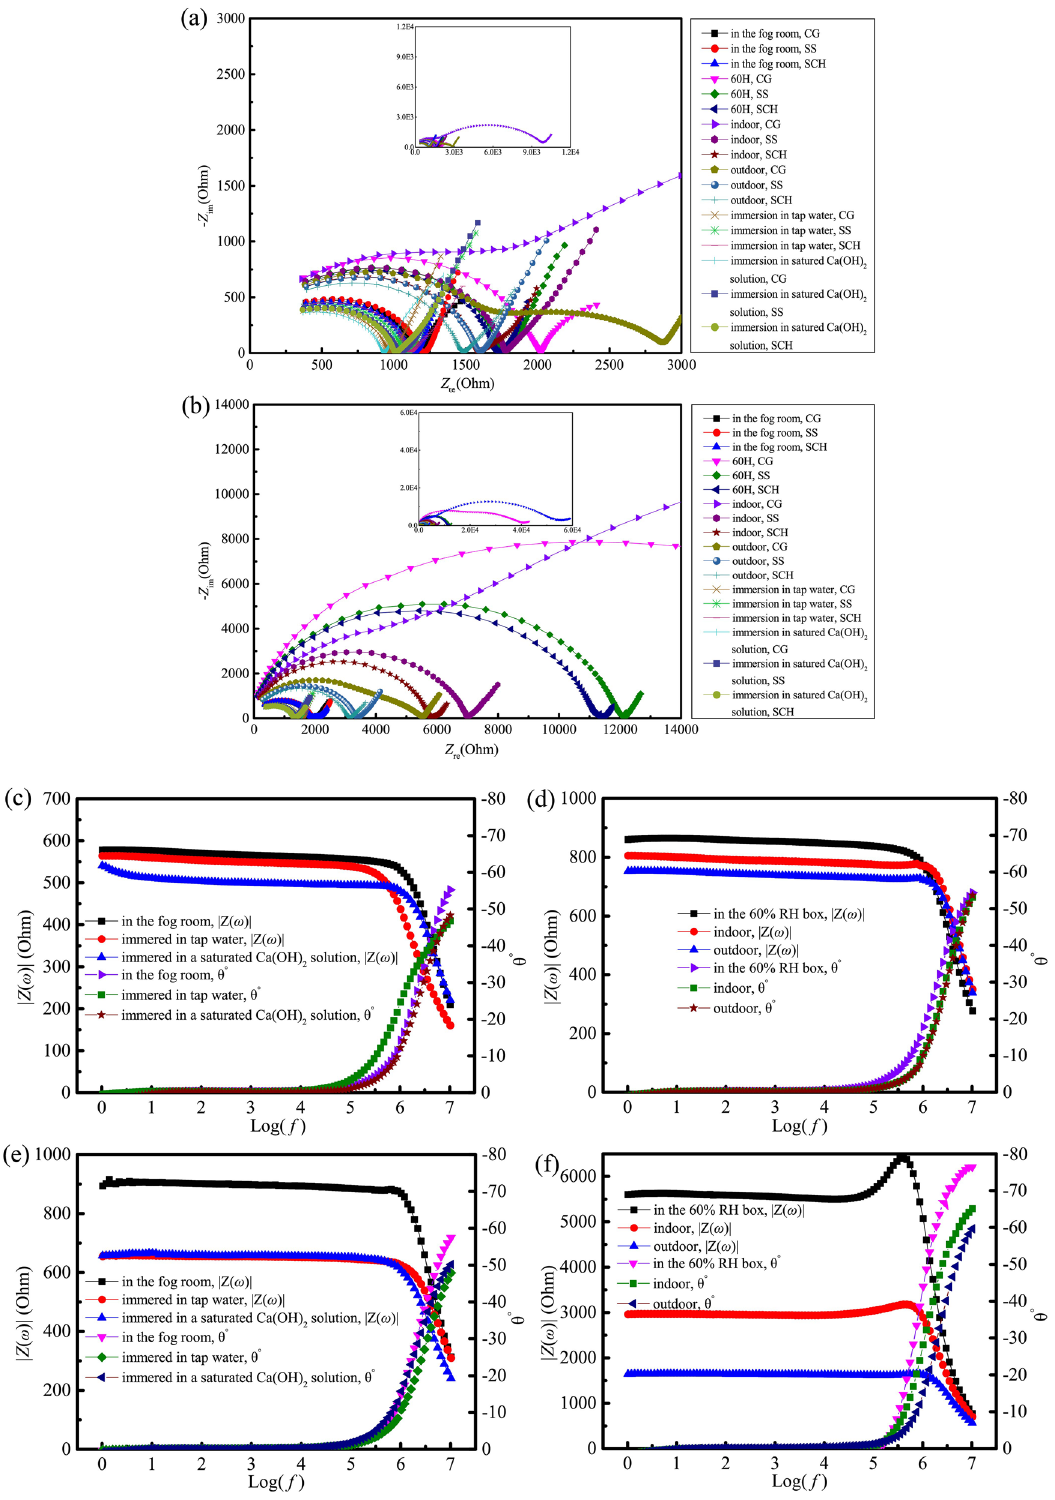
Figure 11. Nyquist plots and Bode plots of samples under different curing conditions. ( a ) Nyquist plots-3d; ( b ) Nyquist plots-28d; ( c ) Bode plots-3d; ( d ) Bode plots-3d; ( e ) Bode plots-28d; ( f ) Bode